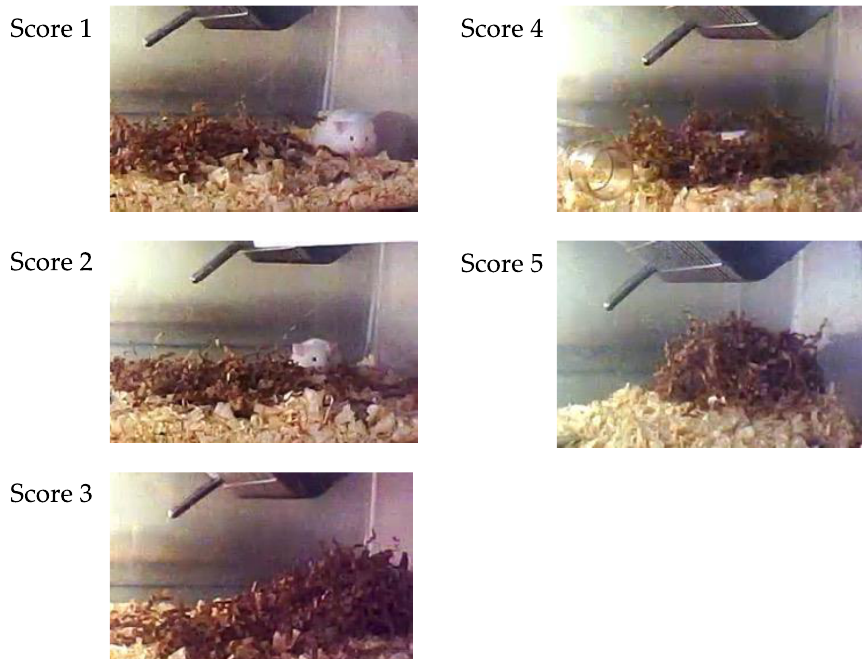
Figure 2. Representative images of nest consolidation scores.